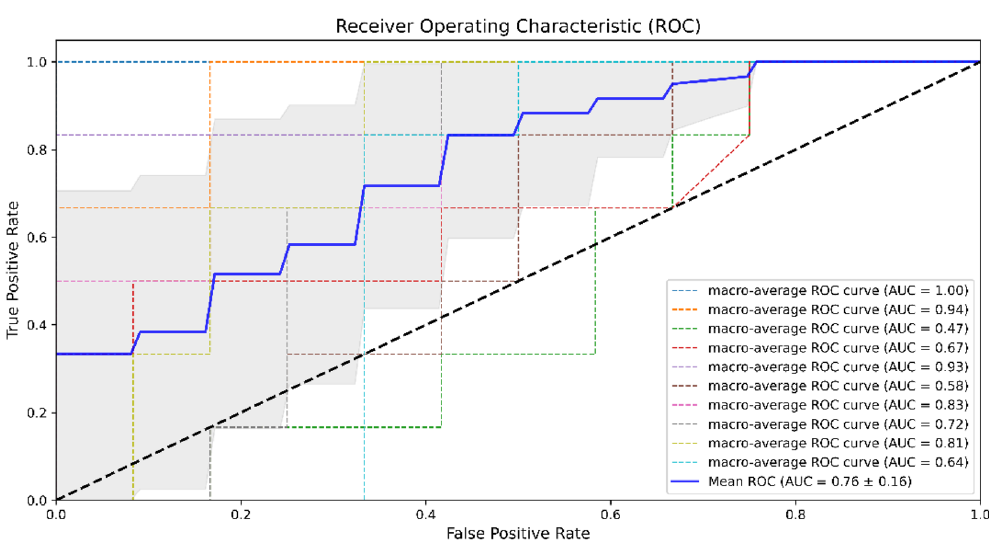
Figure 5. ROC-AUC of the stacking ML model using selected features by